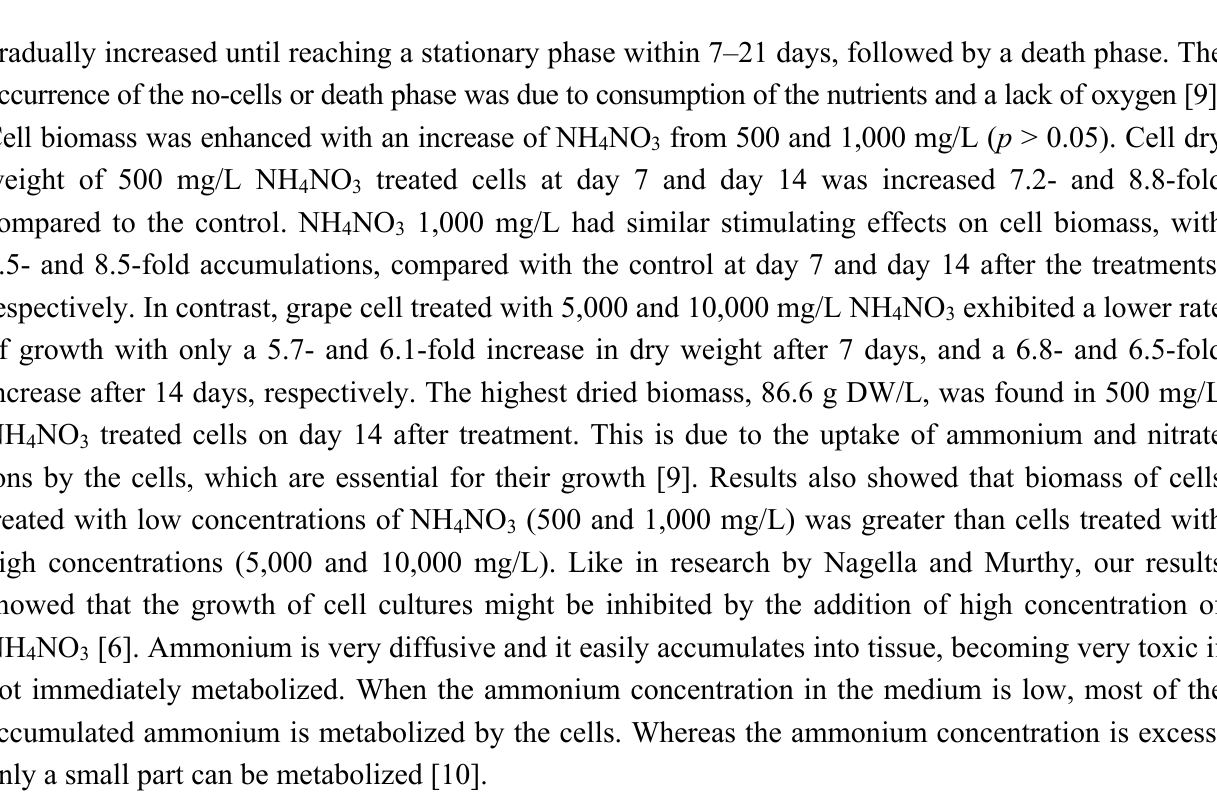
Figure 1. Growth of ‘Pok Dum’ Vitis vinifera cell suspension cultures after being treated with ammonium nitrate 0, 500, 1,000, 5,000 and 10,000 mg/L (control, N 500 mg/L, N 1,000 mg/L, N 5,000 mg/L and N 10,000 mg/L). Data are mean ± SD ( n =